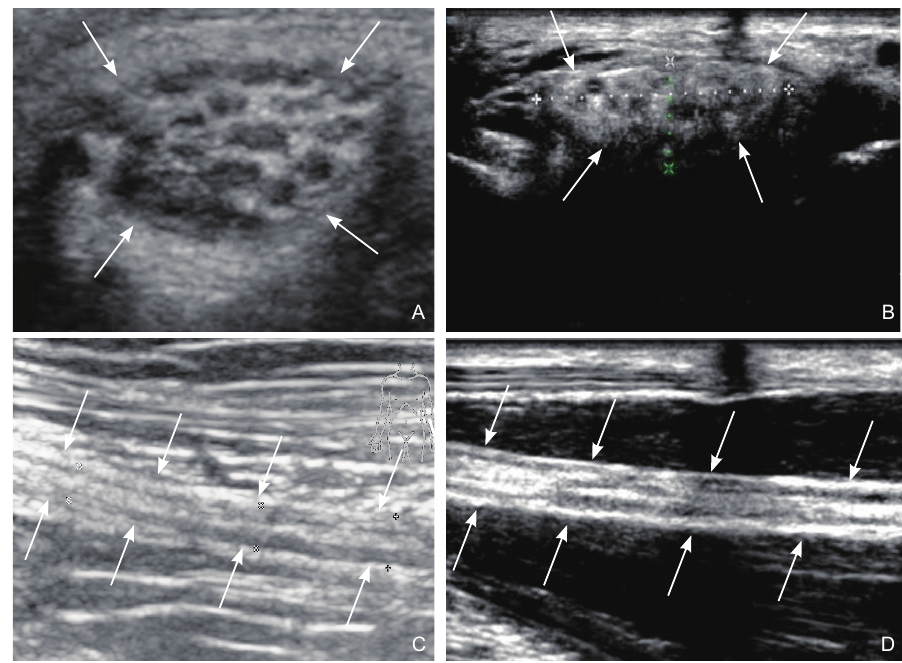
Figure 3 (A-B) Transverse section of lipomatosis of nerve by ultrasonography, showing punctate hypoechoic nerve bundles and hyperechoic fatty tissue, termed as cable-like (arrow); (C-D) Longitudinal section of lipomatosis of nerve by ultrasonography, showing barred hypoechoic nerve bundles and hyperechoic fatty tissue, termed as lotus-like